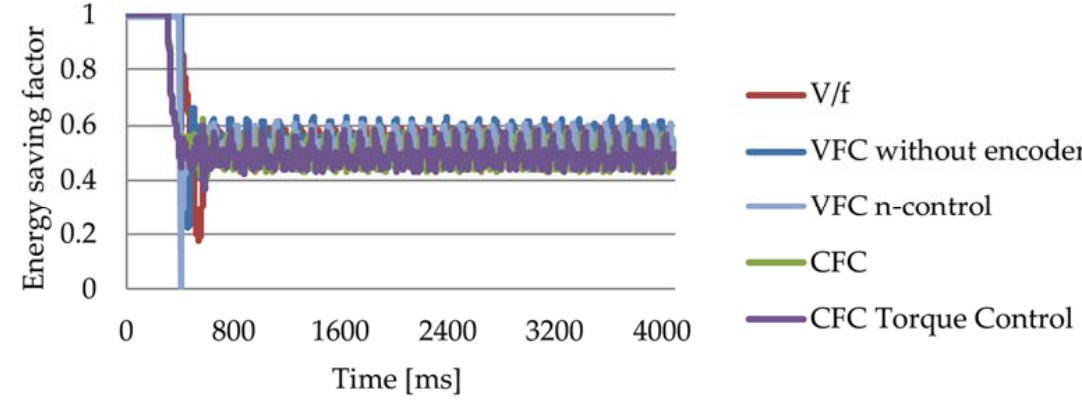
Figure 11. Comparison of the energy saving factor (E SF ) for various control modes (with the external load). Table 17. Characteristics of the energy efficiency E SF in the steady state (with the external